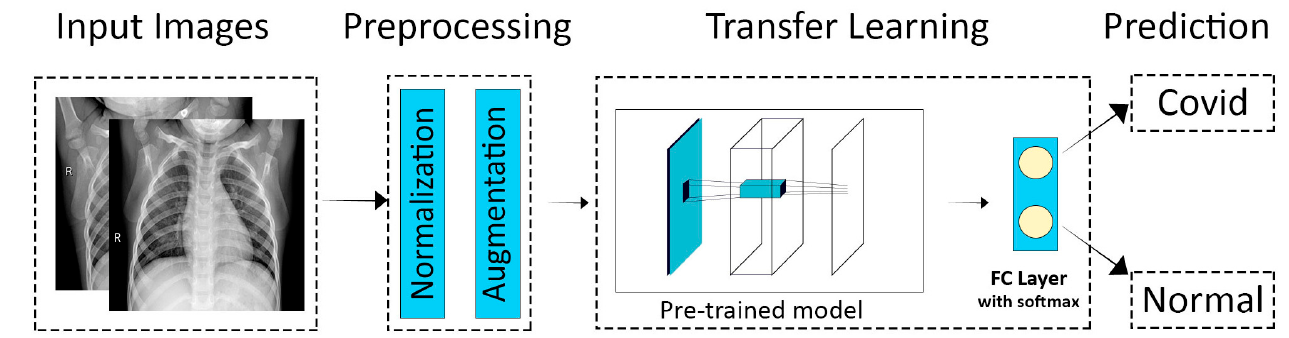
Figure 3. Overview of the transfer learning technique for the diagnosis of COVID-19 [33] .